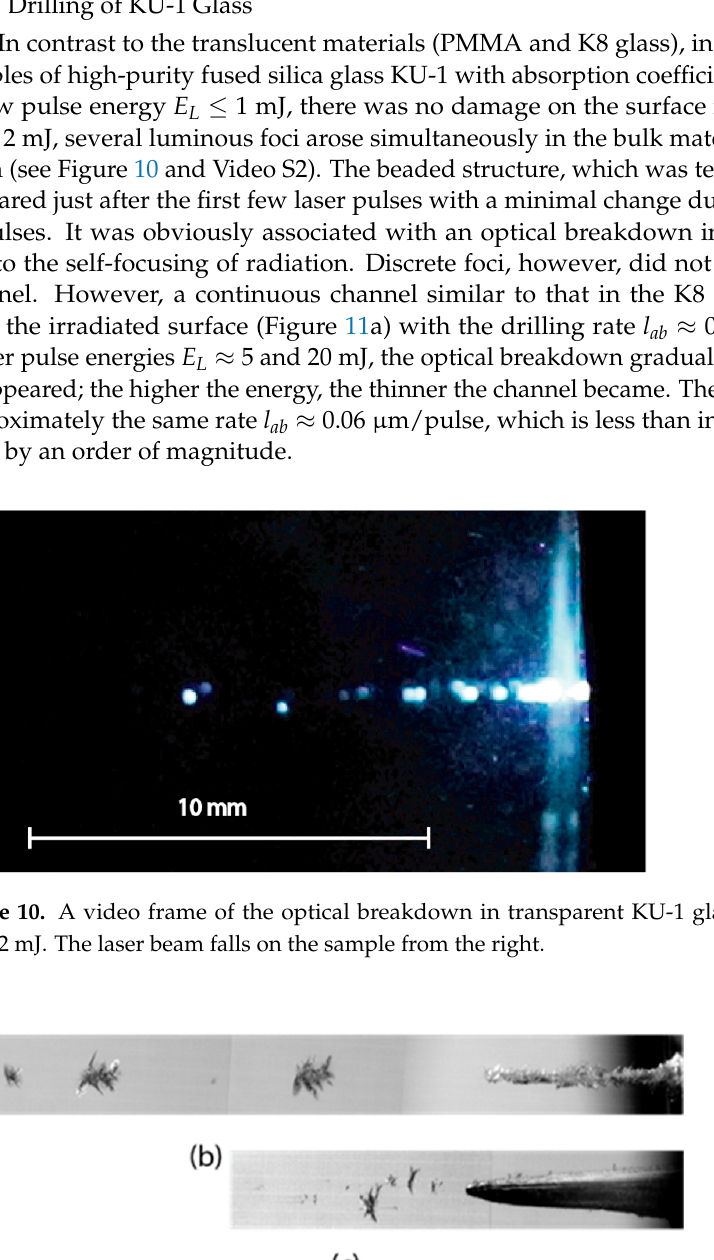
Figure 11. Microscopic images of the breakdown damage and completed channels produced in KU-1